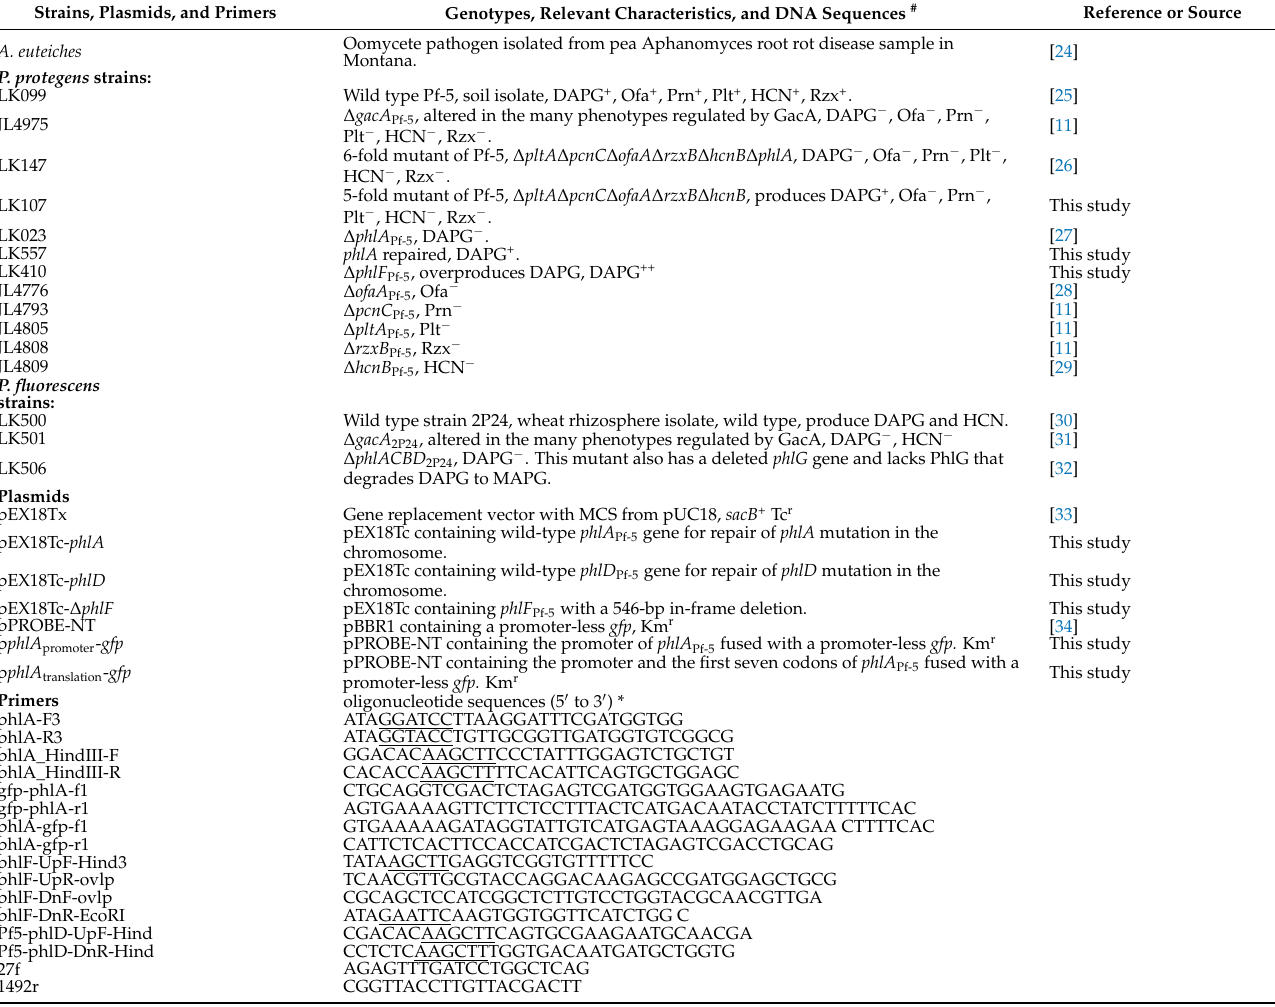
Table 1. Bacterial strains, plasmid, and primers used in this